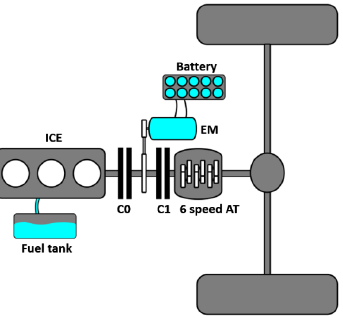
Figure 1. Schematic of the P2 HEV powertrain [18] .